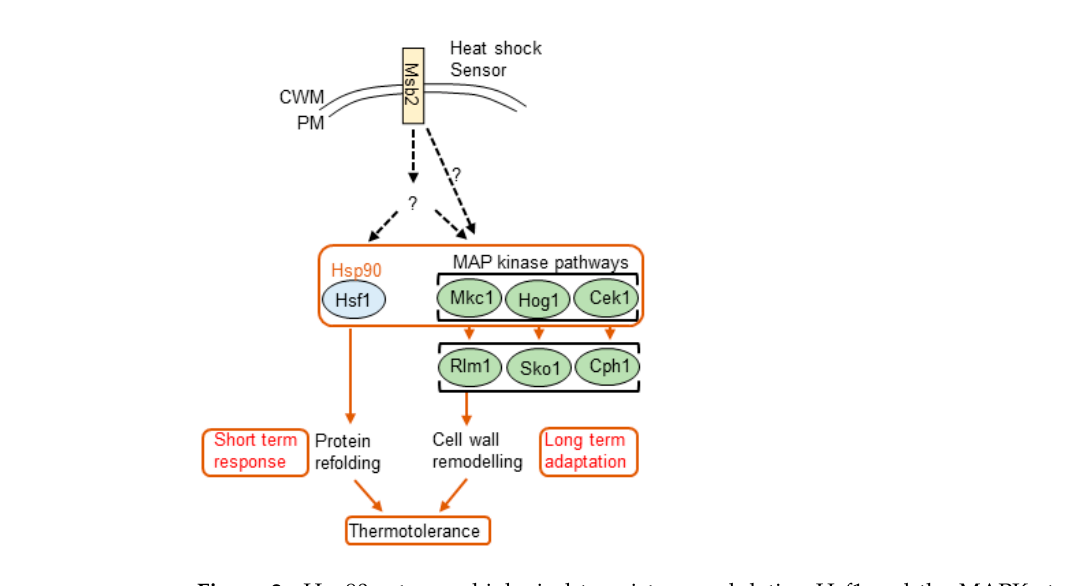
Figure 2. Hsp90 acts as a biological transistor, modulating Hsf1 and the MAPKs transcription factors in response to thermal fluctuations. Msb2 plays a vital role in thermotolerance in C. albicans . The protein transmits heat shock signals through unknown mechanisms that induce downstream targets such as the Pkc pathways in response to high temperatures. Hsf1 activation is required for thermotolerance. The MAP kinase signaling pathways are also required to promote thermotolerance through remodeling the cell wall [117,185]. Because Hsp90 coordinates much of this activity, Hsf1, Hog1, Mkc1, and Cek1 are all thought to be Hsp90 client proteins [177,181]. Fluctuations in ambient temperature affect interactions between Hsp90 and Hsf1, and probably affect Hsp90 interactions with the MAP kinase transcription factors [181], thus modulating the role of the signaling pathways and thermal adaptation outcome. Temperature upshifts activate Hsf1, which induces the expression of protein chaperones (HSPs), including Hsp90, which promotes shorter term thermal adaptation. It is thought that Hsp90 then down-regulates Hsf1 and modulates MAP kinase signaling, to alter cell wall architecture, which leads to long term thermotolerance in C. albicans . Adapted from [177]. Broken lines indicate unconfirmed regulatory mechanisms.